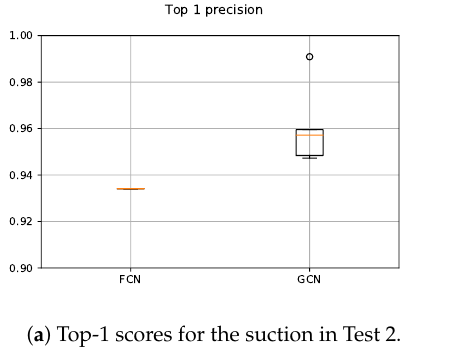
Figure 16. Obtained precision scores per confidence percentiles for the suction models in Test 2.